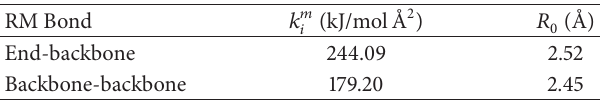
Table 6: Parameters for reduced model intramolecular Hamilto-